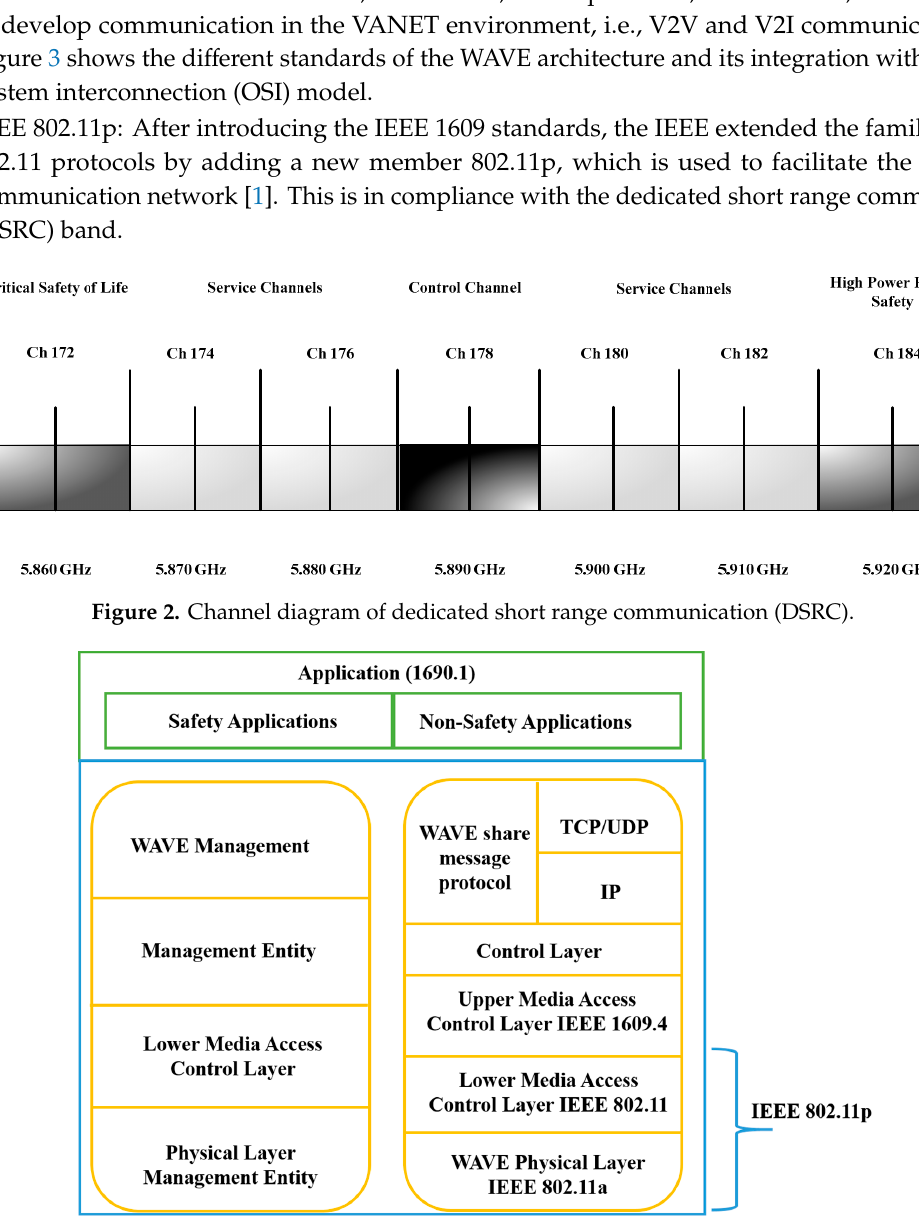
Figure 3. Wireless access in vehicular environments ( WAVE) architecture.